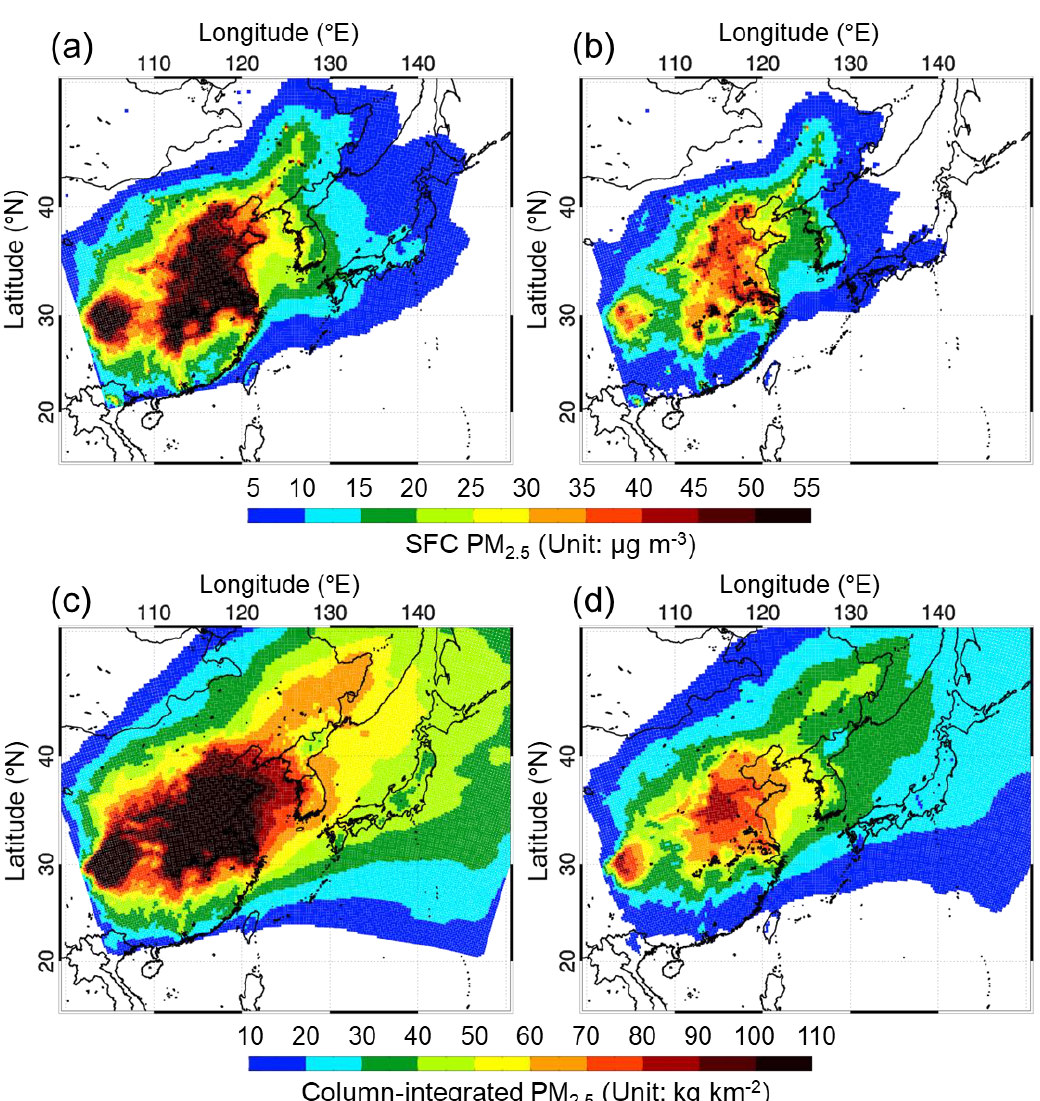
Figure 5. Comparisons of horizontal PM 2.5 distributions of surface concentrations ( a , b ), and column- integrated concentrations ( c , d ) from two modules, MADE/VBS and MADE/SORGAM, respectively.